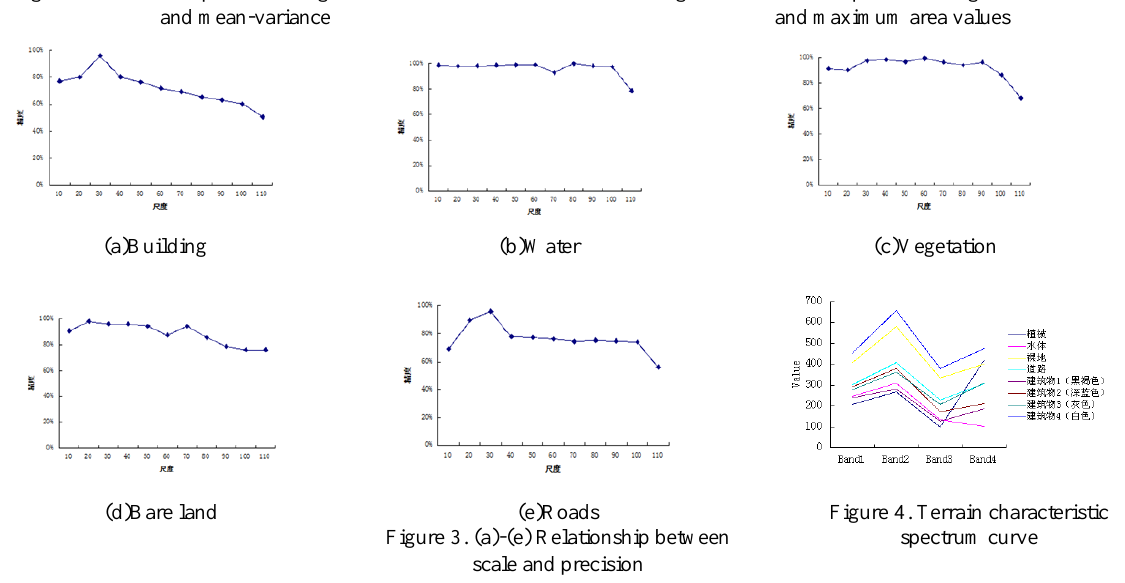
Figure 3. (a)-(e) Relationship between scale and precision